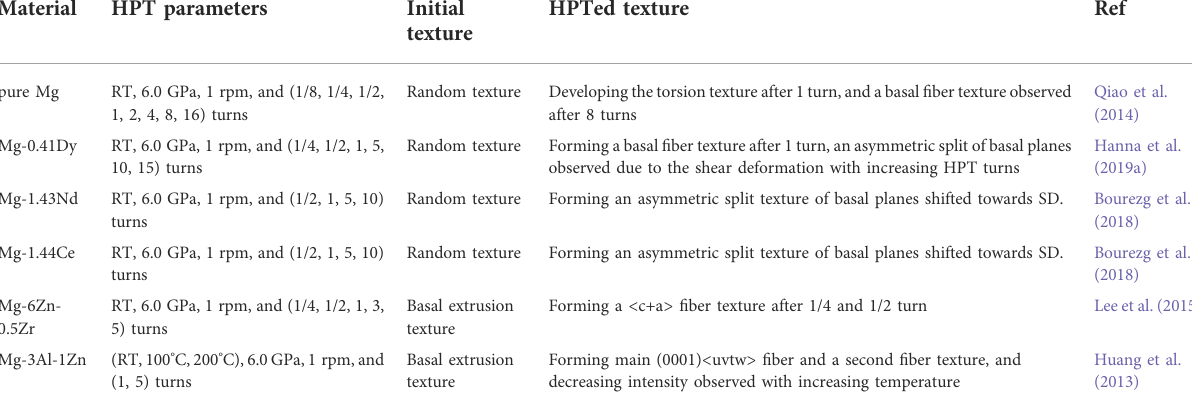
TABLE 2 Texture evolution of HPTed Mg alloys examined in the left as a function of HPT turns.